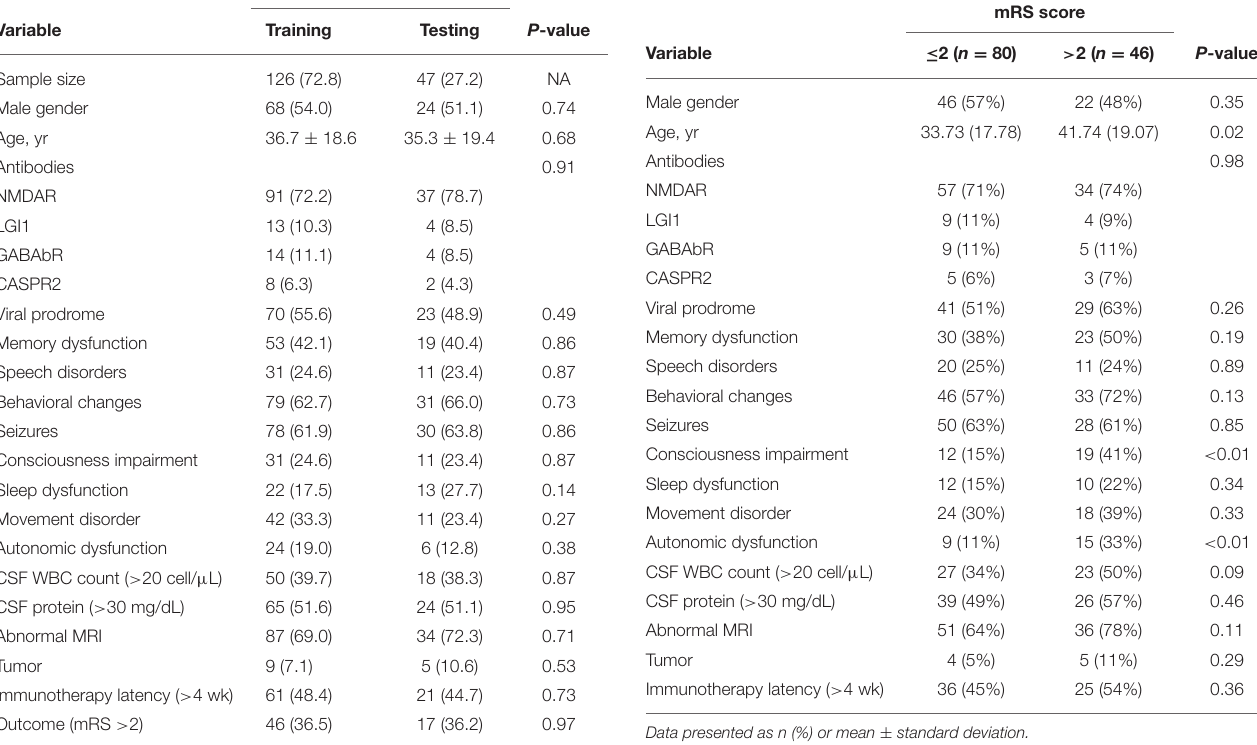
TABLE 1 | Summary of study variables stratified by data set.